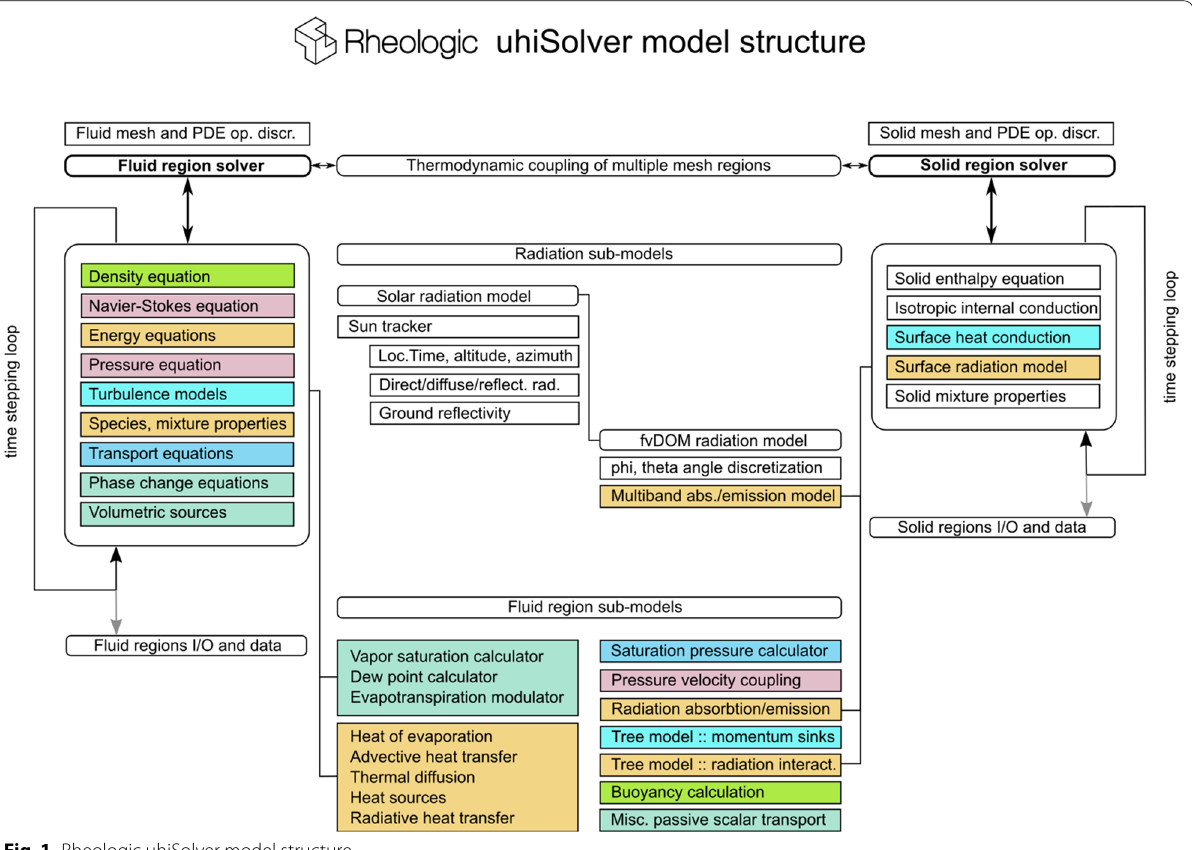
Fig. 1 Rheologic uhiSolver model